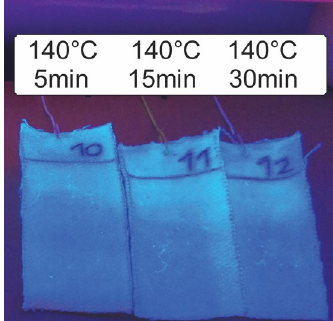
Figure 10. Textile samples treated with the different solutions under illumination with a UV-lamp. The process temperature of 140 °C and process duration for solution preparation is indicated for each sample. After application of the solution, the textile samples are dried at 120